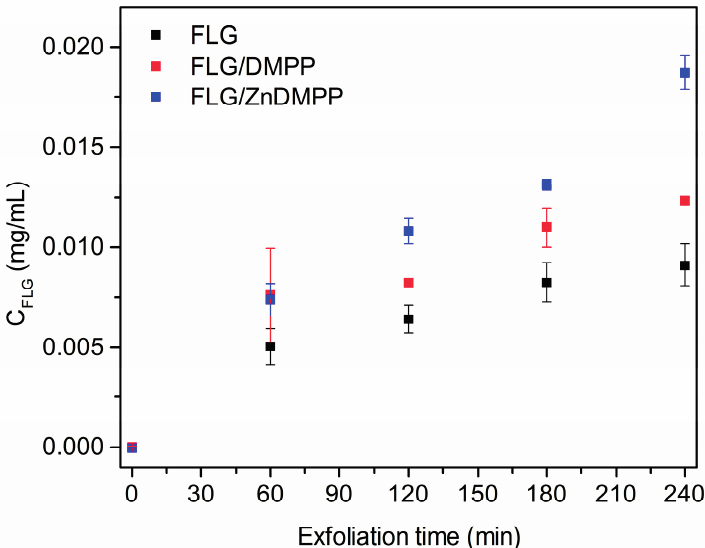
Figure 3. Concentration of FLG ( C FLG ) vs. exfoliation time obtained in pure 1-methyl-2-pyrrolidone (NMP) (black squares) and in the different porphyrin solutions. Each data point represents the mean of three separate experiments and error bars are standard